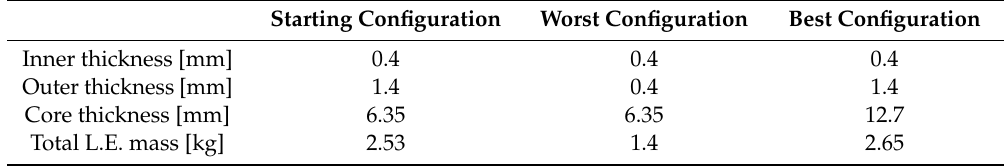
Table 4. Design parameters of the starting, the best and the worst configuration. Starting